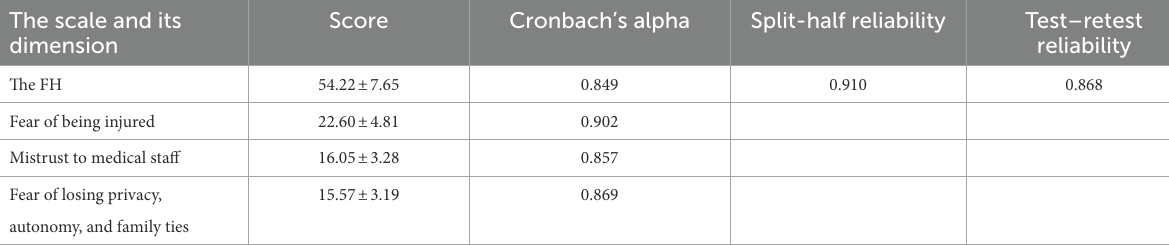
TABLE 4 Reliability analysis for the Chinese version of the FH